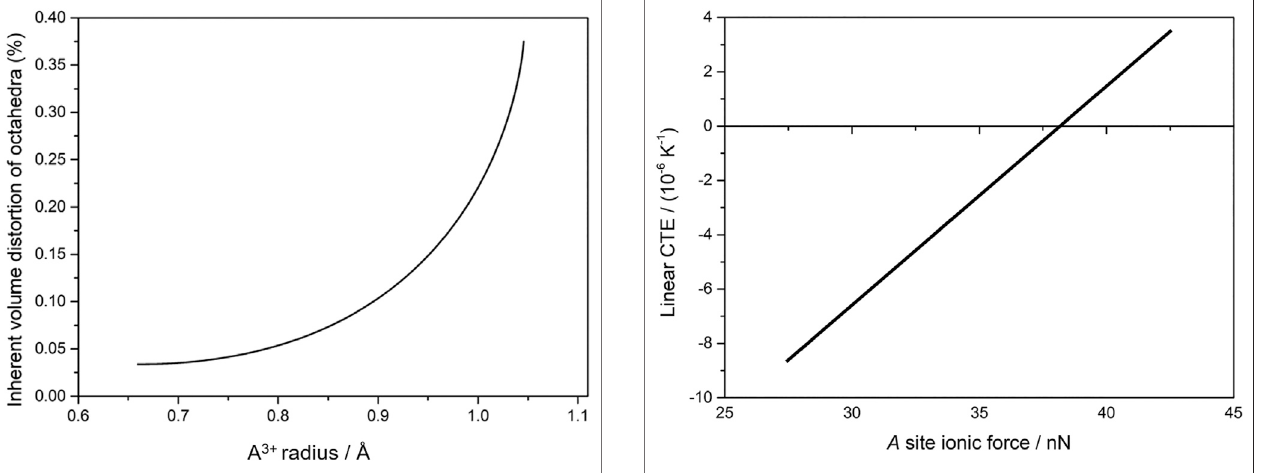
FIGURE 8 | Schematic view of the dependence between inherent volume distortion of octahedra and radius of A 3+ in the A 2 M 3 O 12 family (styled from data in Romao et al., 2015b).